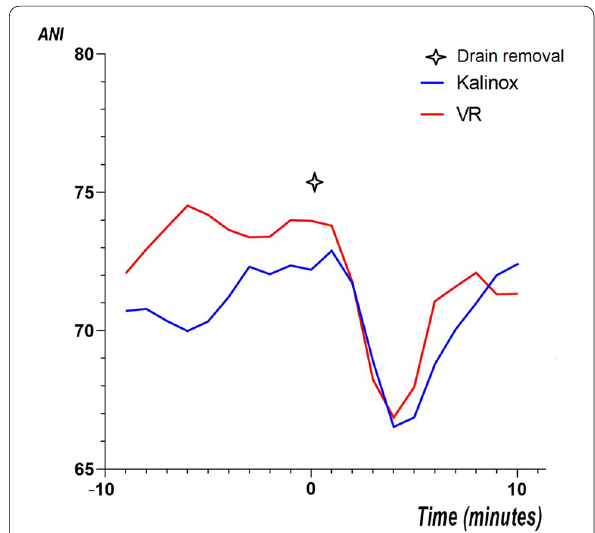
Fig. 2 ANI variation during procedure. ANI values 0–100 points (low values indicating higher levels of pain). ANI analgesia/nociception